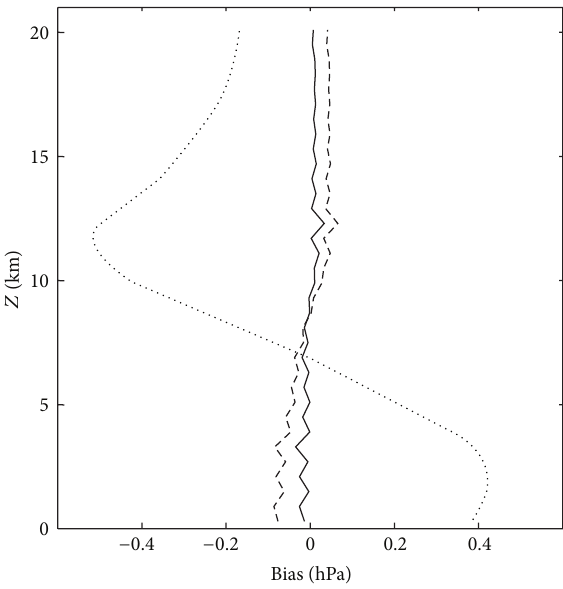
Figure 4: Vertical profiles of horizontal domain-wide bias in 𝑝 2 (dotted), 𝑝 (solid), and 𝑝 retrieved with the hydrometeor drag final final term omitted in the cost function